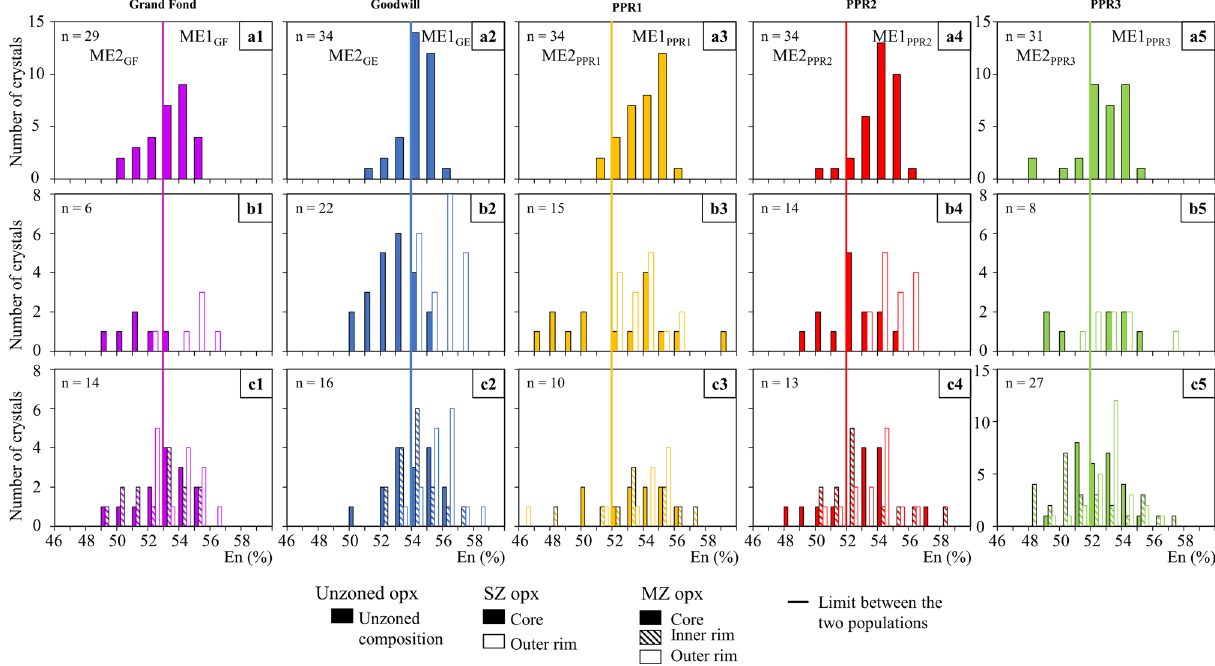
Figure 3. Frequency histograms of the En content of unzoned ( a1 – a5 ) and zoned opx of the five studied eruptions (single-zoned (SZ) opx: b1 – b5 and multiple-zoned (MZ) ones: c1 – c5 ). These frequency histograms highlight two populations of opx: a first population of zoned opx with cores that have the same composition as the majority of the unzoned opx (population 1 in Fig. 4) and zoned opx with cores with lower En contents (less magnesian) than the unzoned opx (population 2 in Fig. 4). The boundary between these two populations are shown with a line on the Figure: En 53 for Grand Fond, En 54 for Goodwill and En 52 for PPR1 to 3. The color for each eruption is the same as in Fig. 2. The magmatic environments (ME) discussed afterwards are specified here for each eruption. n: number of opx